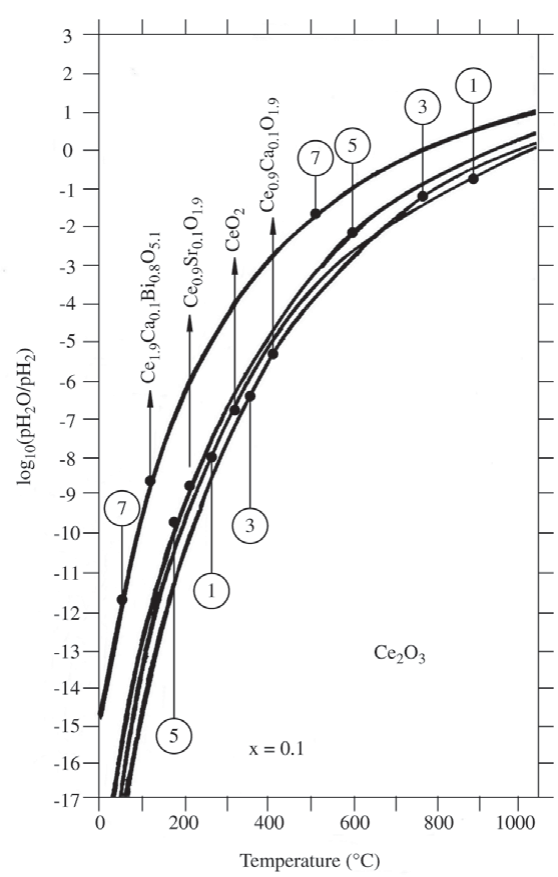
Figure2. Diagram of log cerias doped with Ca, Sr and Bi; x =